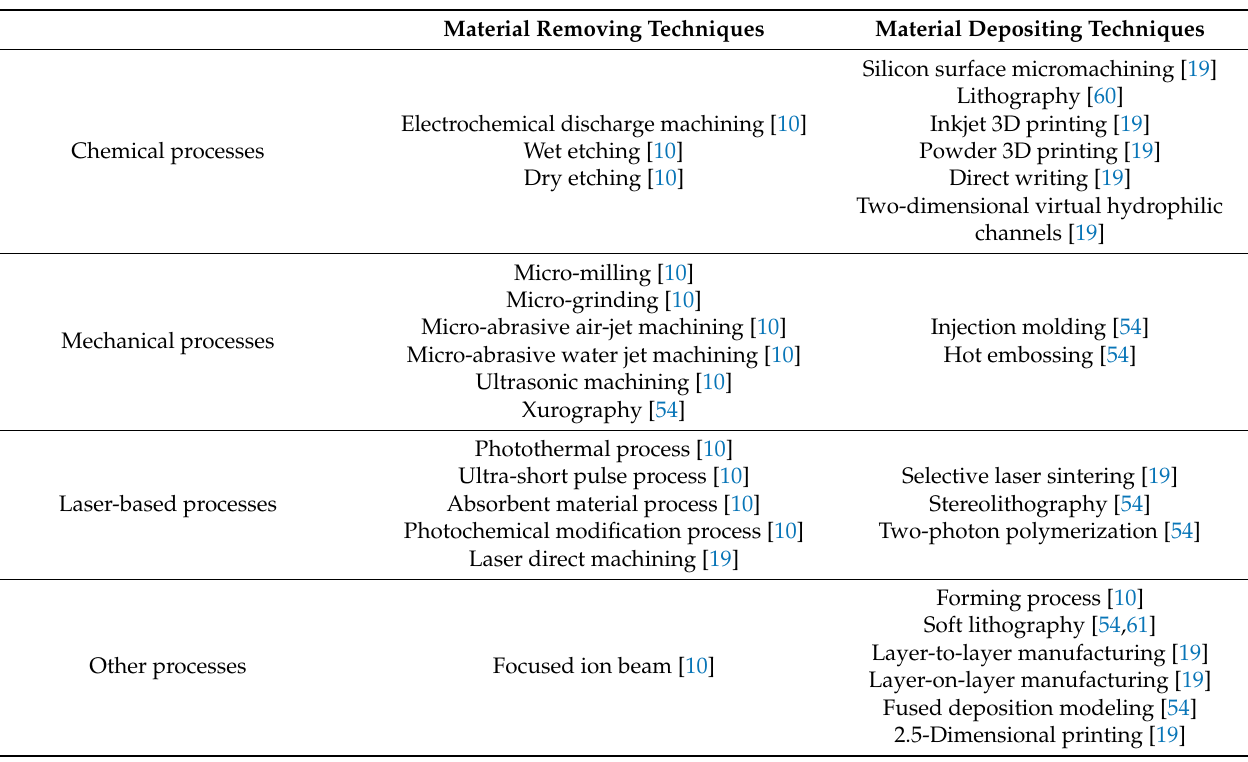
Table 2. The classification of microfluidic fabrication